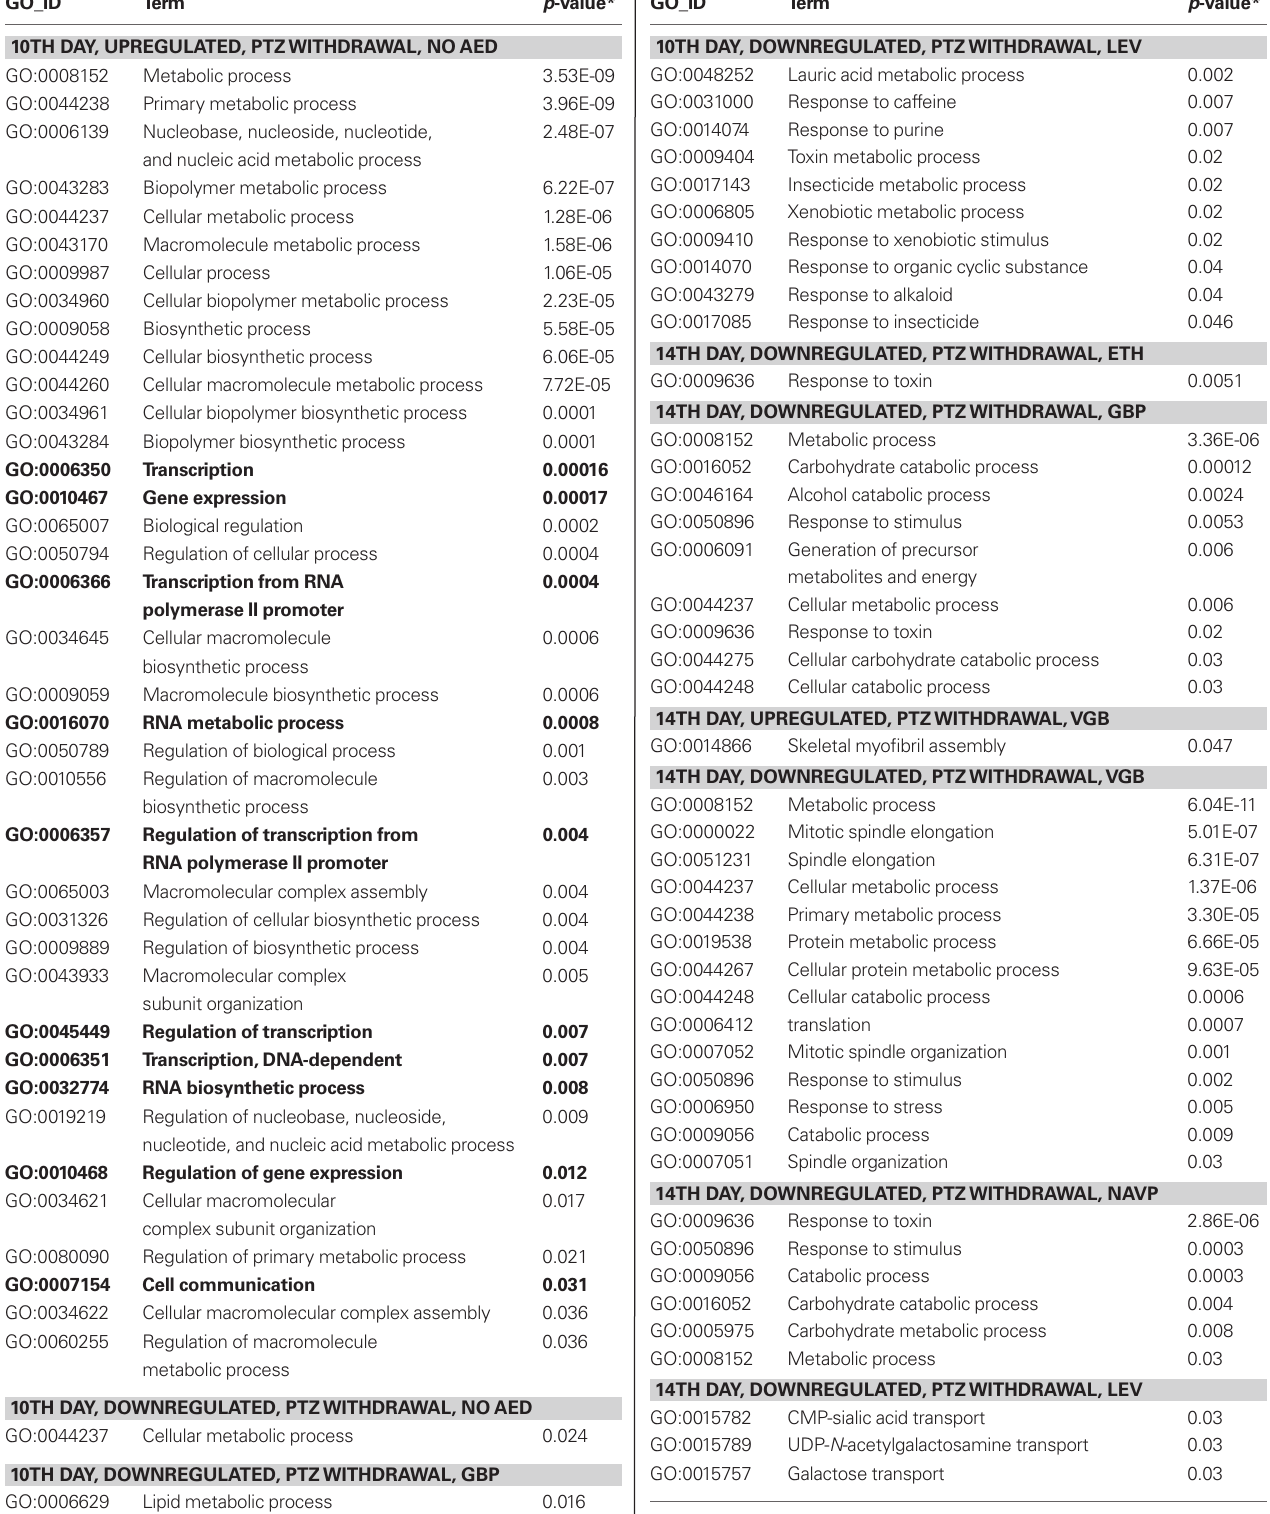
Gene expression and cell communication related processes are highlighted in bold. *After Bonferroni